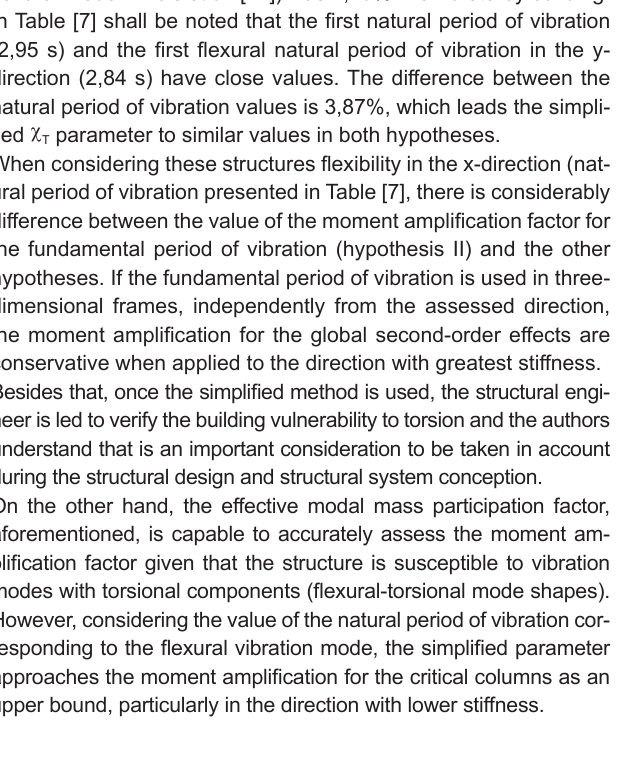
Overturning base moment of critical columns for 12-storey and 13-storey structures – Model 9 Number of